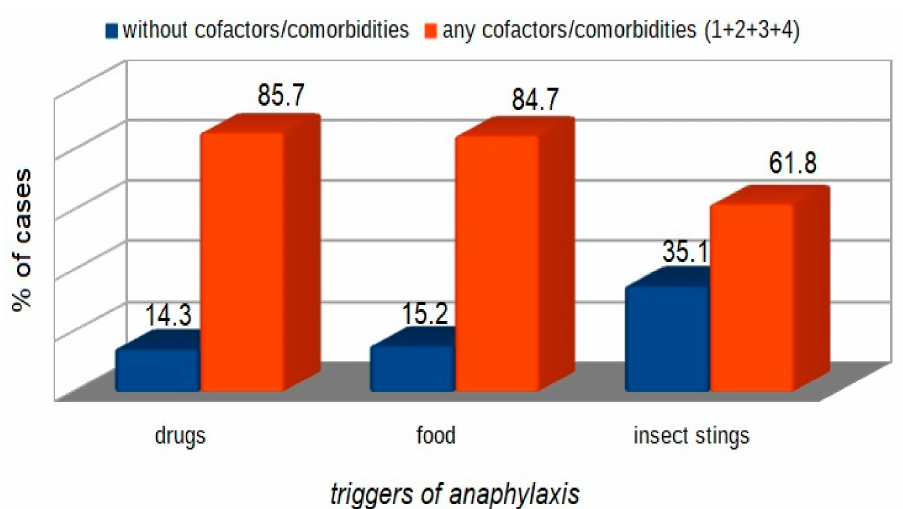
Figure 6. Comparison of patient subgroups depending on the trigger of anaphylaxis and presence or absence of comorbidities (insect stings p < 0.001, food p < 0.001, drugs p < 0.001).